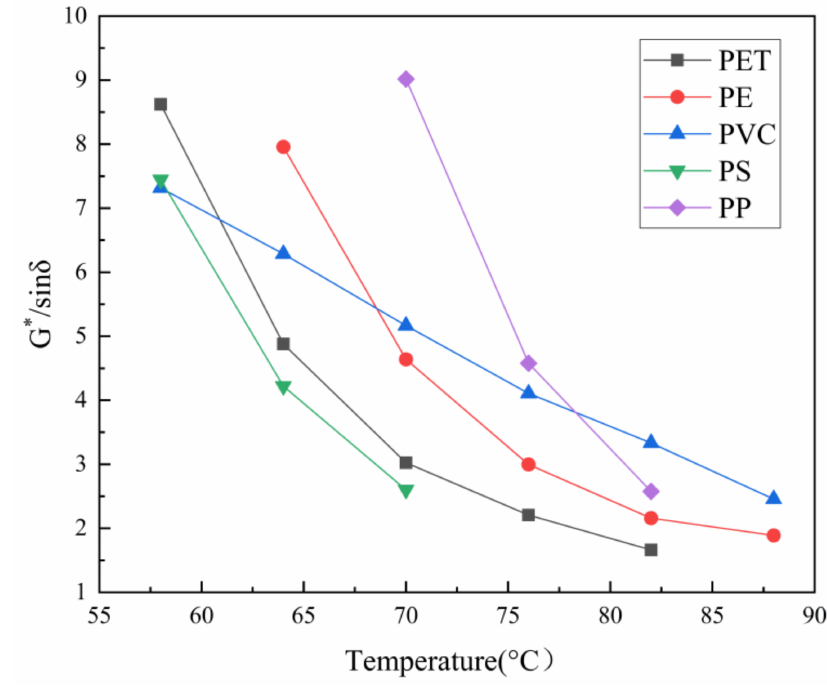
Figure 3. Rheological results of various waste plastic-modified asphalts